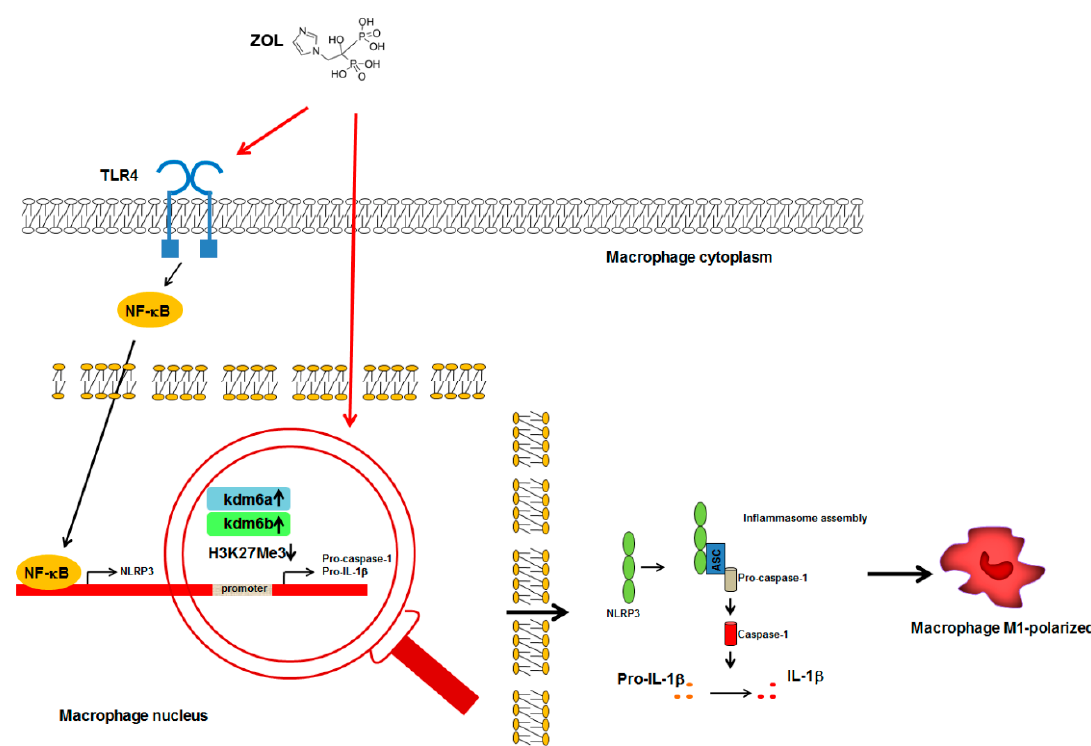
Figure 1. Schematic representation of ZOL-macrophage cross-talk mechanisms. ZOL-mediated activation of TLR4 in macrophages accounted for the overexpression of mature form of IL-1 β leading to M1- polarization. Red arrows indicate the action of ZOL on TLR4 activation and Kdm6 proteins overexpression. (